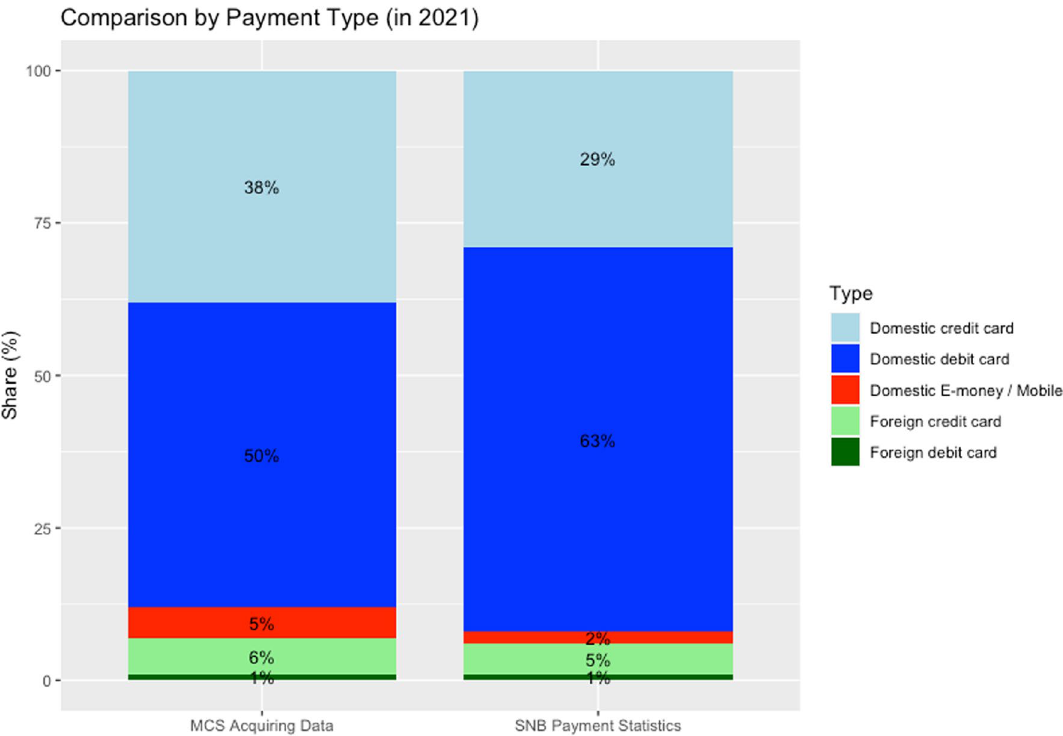
Fig. 4 Comparison of MCS acquiring data to SNB payment statistics, 2021. Note : The figure displays the distribution of different payment methods in the acquiring data against the official distribution of payment methods in Switzerland according to the SNB. Data source: MCS_Overview_Data. csv, SNB Payment and Cash Withdrawals (https:// data. snb. ch/ en/ topics/ finma/ cube/ zavez